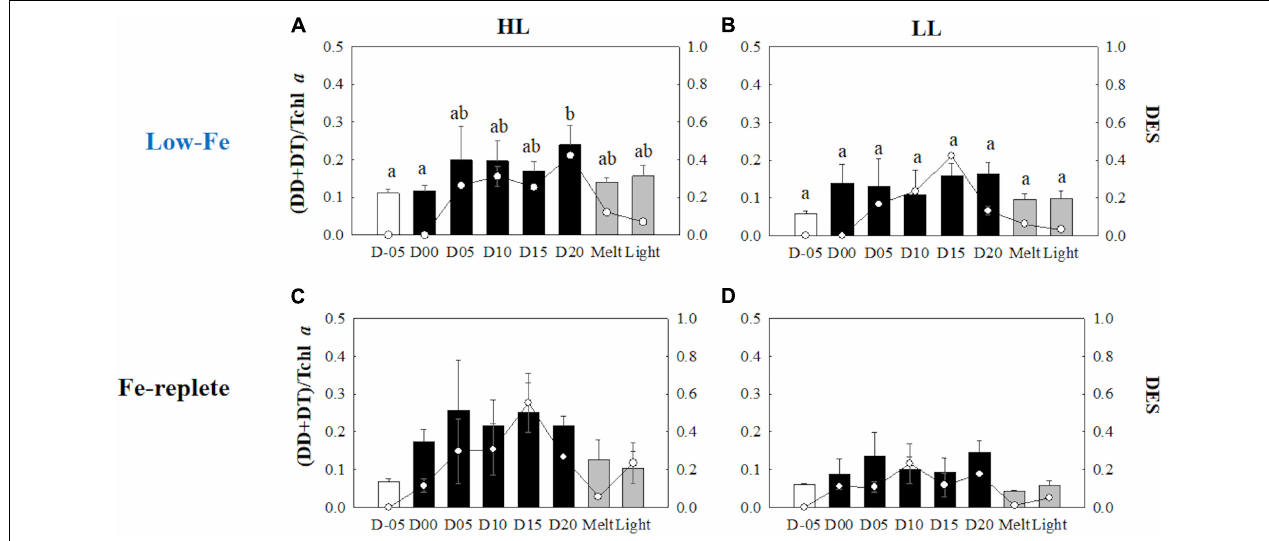
FIGURE 10 | Xanthophyll pool size [(DD + DT)/Tchl a ] and xanthophyll de-epoxidation states (DES) at each sampling time point during the ice tank incubation experiments. Panels (A,B) show xanthophyll pool size (bars, left axis) and DES (markers, right axis) of the low-Fe ice tank runs in this study, whereas panels (C,D) show those of Fe-replete ice tank runs modified from Yoshida et al. (2020). Left (A,C) and right (B,D) panels indicate data from the HL and LL treatments, respectively. Open, closed, and shaded bars indicate values of pre-freeze seawater, ice, melted seawater samples, respectively. Letters above bars in a panel indicate significant differences in values between sampling days and light treatments with one-way/two-way ANOVA with Tukey’s test; there is no significant difference between values if a given letter is shown in the combination of letters of the counterparts. The D stands for “day,” while Melt and Light indicate values after melting and light exposure experiments, respectively. Error bars show 1 standard deviation ( n = 3). Xanthophyll pool size: One-way ANOVA with Tukey’s test, HL: F ( 7 , 23 ) = 3.03, p = 0.032, LL: F ( 7 , 23 ) = 2.00, p > 0.05; Two-way ANOVA with Tukey’s test, Light: F ( 1 , 46 ) = 4.55, p = 0.041; Day: F ( 7 , 46 ) = 2.26, p > 0.05; Light*Day: F ( 1 , 46 ) = 0.40, p < 0.05. DES: One-way ANOVA with Tukey’s test, HL: F ( 7 , 23 ) = 771.14, p < 0.001; LL: F ( 7 , 23 ) = 188.50, p < 0.001. Two-way ANOVA test with Tukey’s test, Light: F ( 1 , 46 ) = 61.35, p < 0.001; Day: F ( 7 , 46 ) = 11.51, p < 0.001; Light*Day: F ( 7 , 46 ) = 14.01, p < 0.001. A significant interaction between the light availabilities and sampling time points was observed. The results of Tukey’s test, as q -values, are given in the